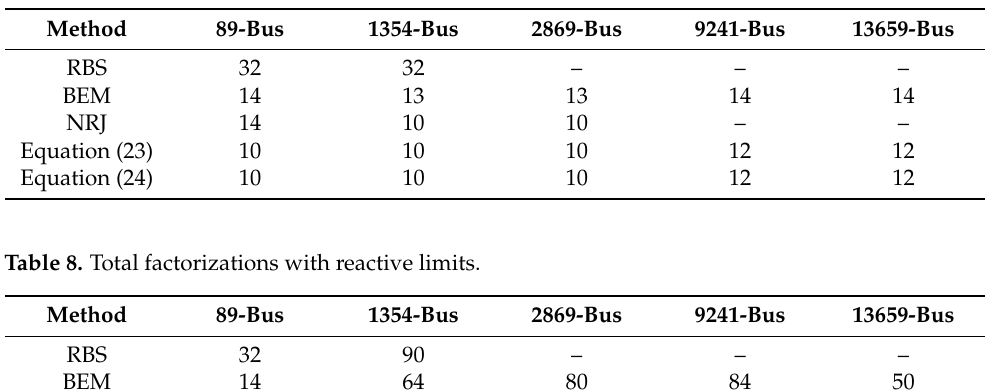
Table 7. Total factorizations for base cases.